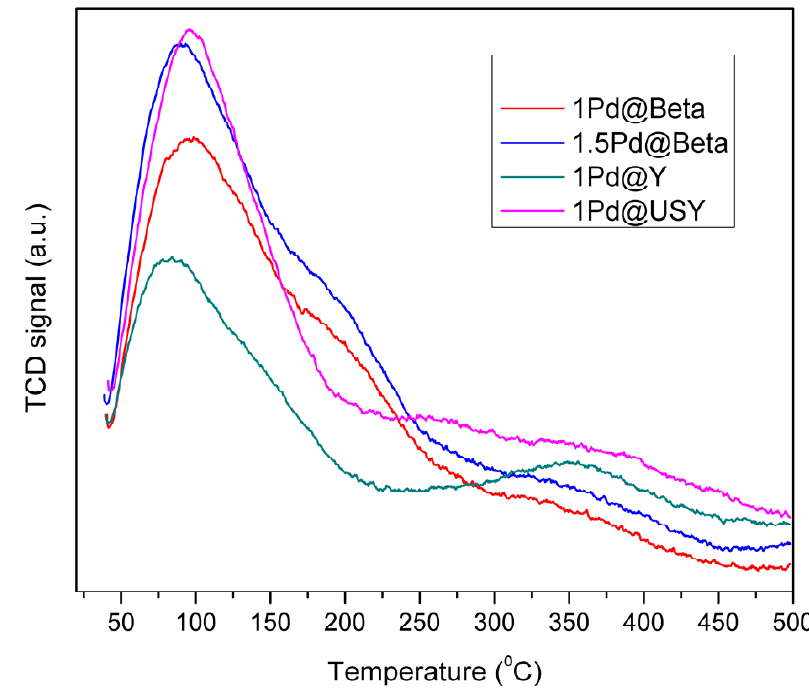
Figure 12. Temperature-programmed desorption profiles of ammonia for the investigated Pd@zeolites. Table 3. Acid site concentration determined through NH3 ‐ TPD measurements.